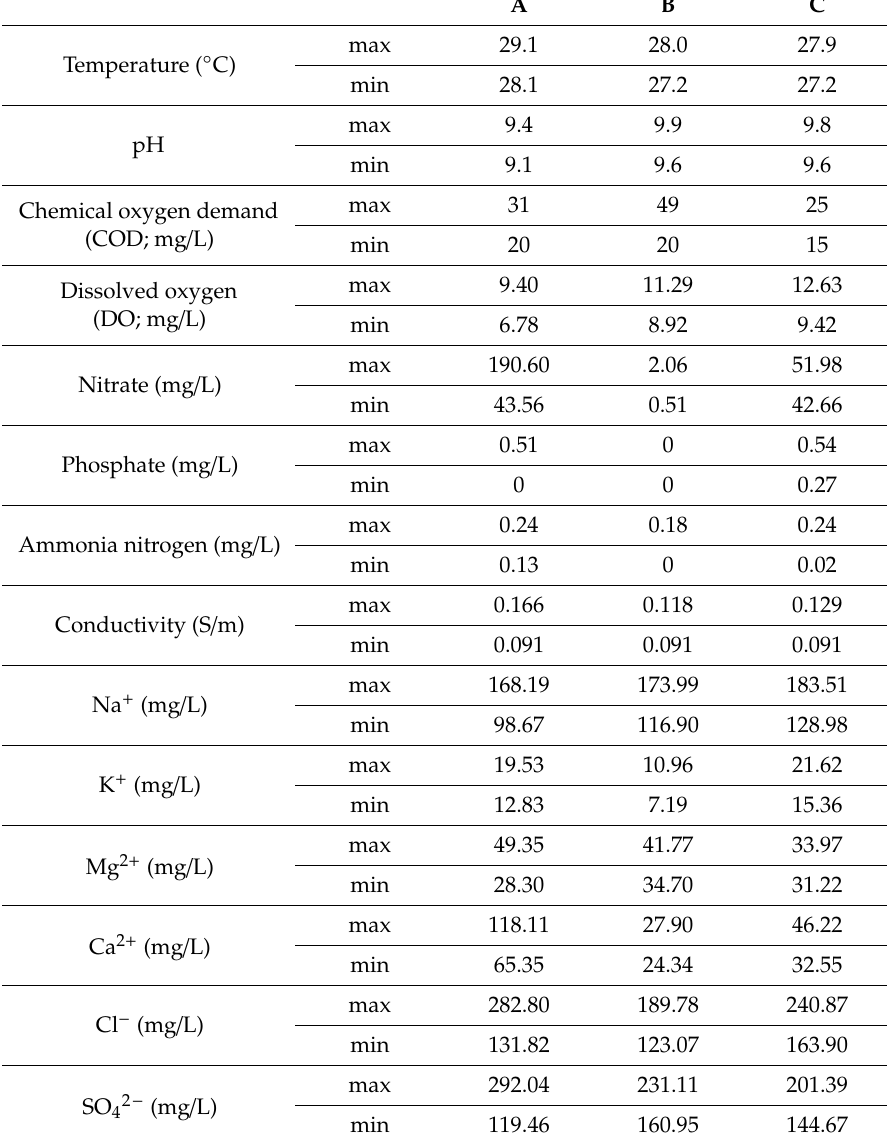
Table 1. Water quality parameters in di ff erent devices (A, B and C). A